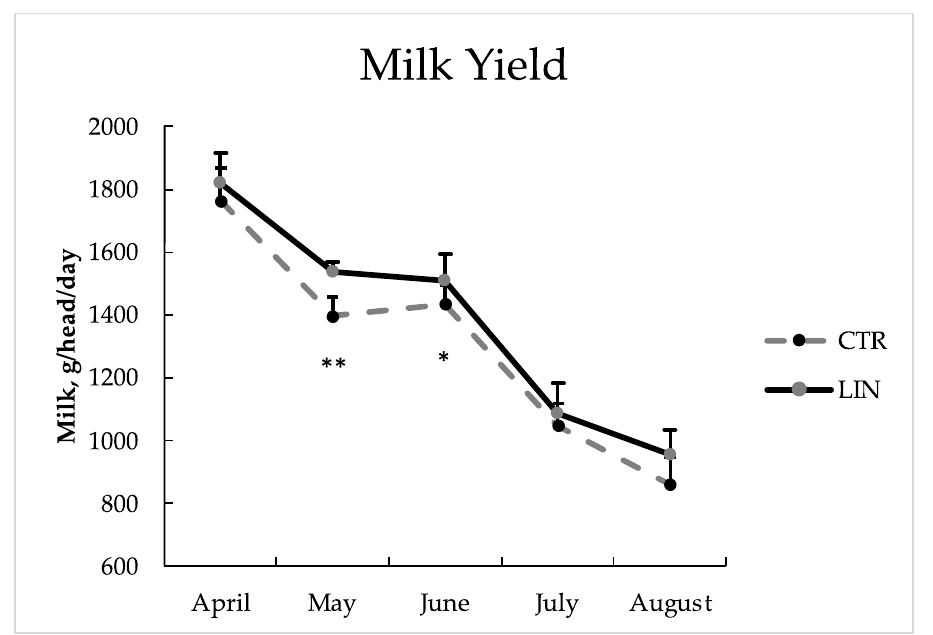
Figure 2. Goats’ milk production (mean ± SD) during the experimental period of control (CTR) and linseed supplementation (LIN) groups. ** p < 0.01; * p < 0.05.